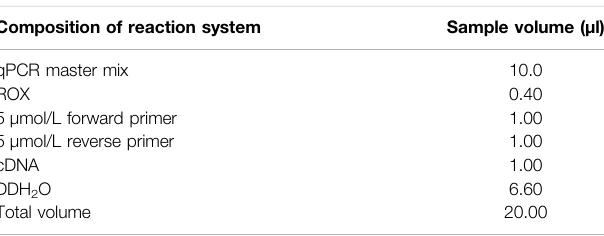
TABLE 2 | Real-time PCR composition of reaction